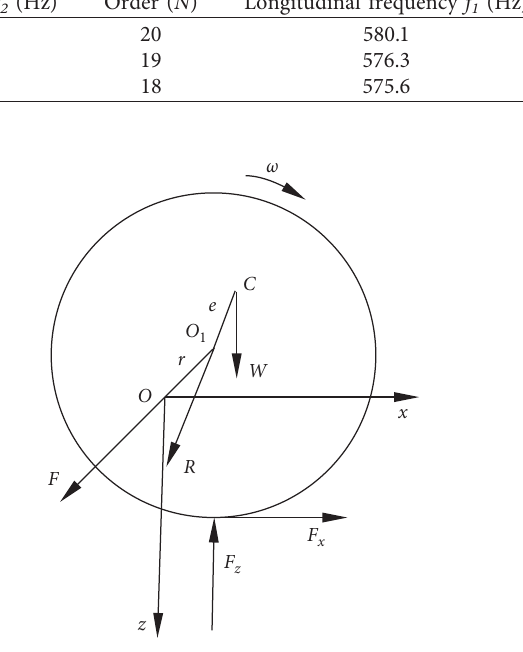
Figure 3: Disk instantaneous position and force.